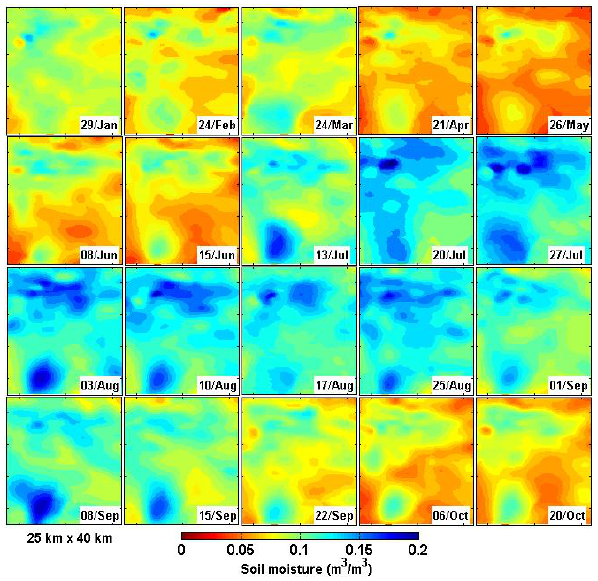
data in 2012. The urban area and agricultural fields have anoma- lously high soil moisture values that persist throughout the duration of the